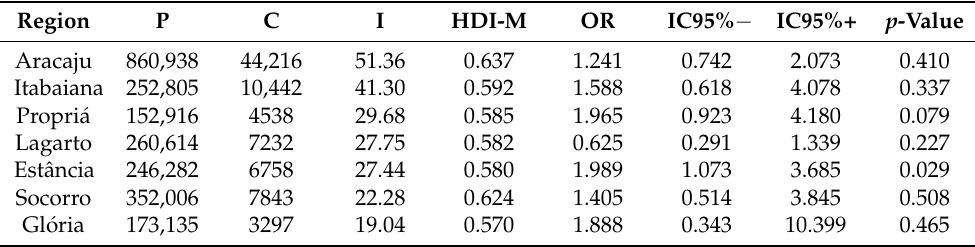
Table 3. Relation between incidence of COVID-19 cases and HDI of health regions in Sergipe—April